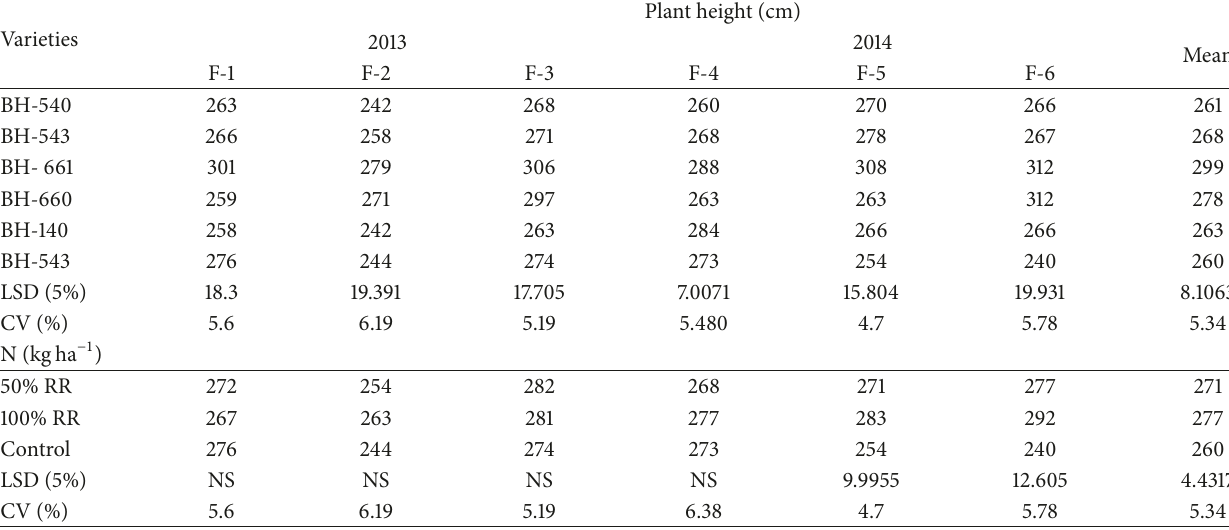
Table 4: Effects of varieties and nitrogen rate on mean plant height of maize on farmer’s field around Bako Tibe, western Ethiopia.